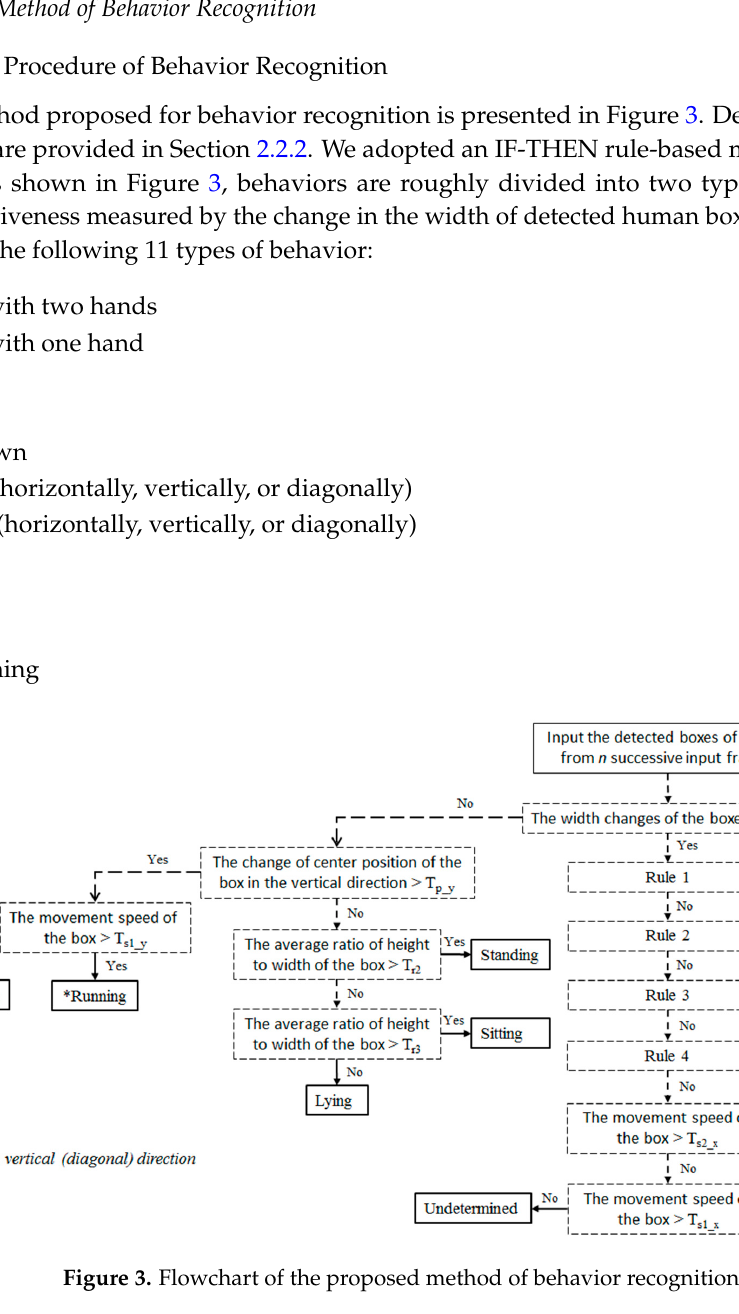
Figure 2. Comparison of different camera setup used in ( a ) previous research; ( b ) our research.